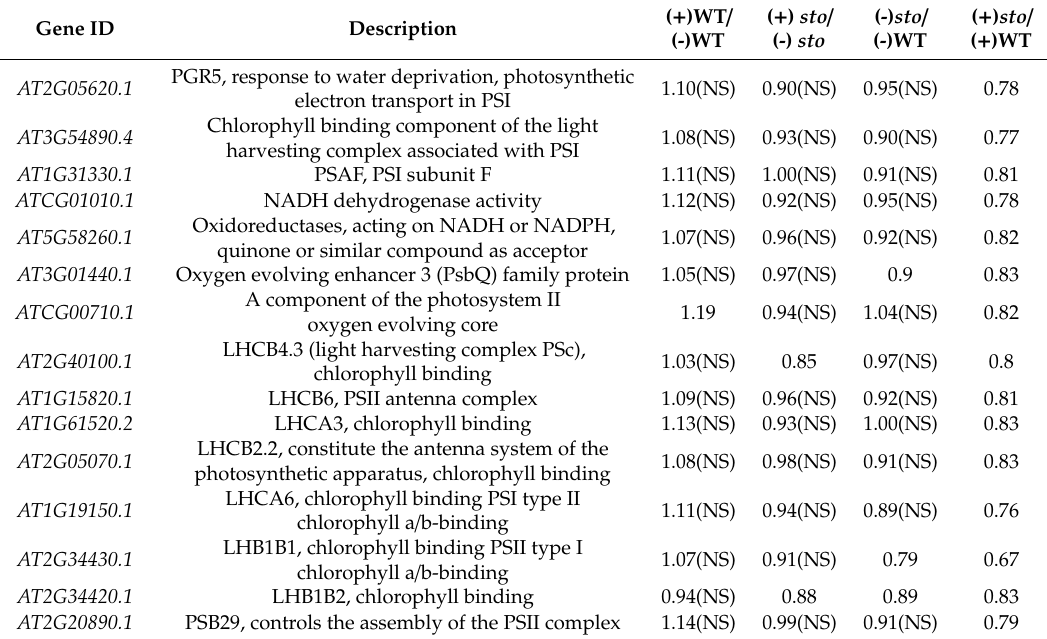
Table 4. Fold changes of di ff erential proteins in the photosynthesis pathway in di ff erent